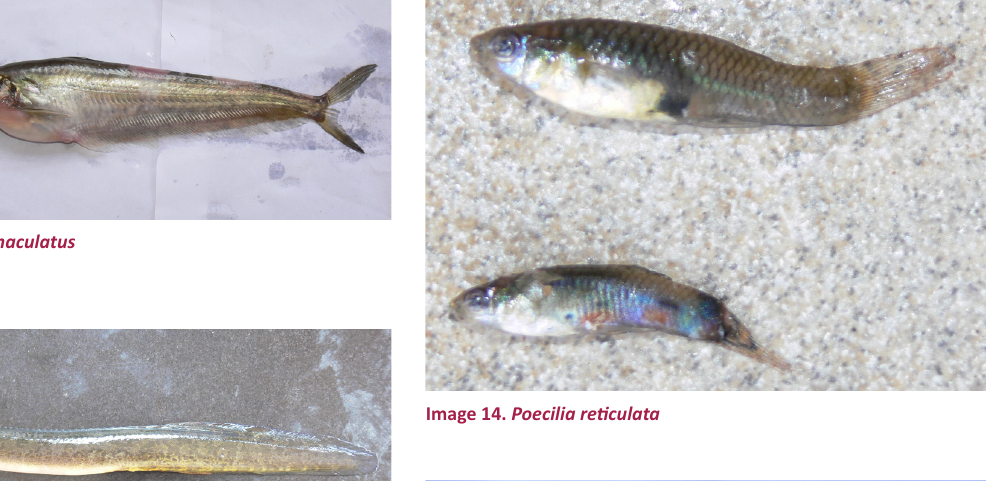
Image 14. Poecilia reticulata